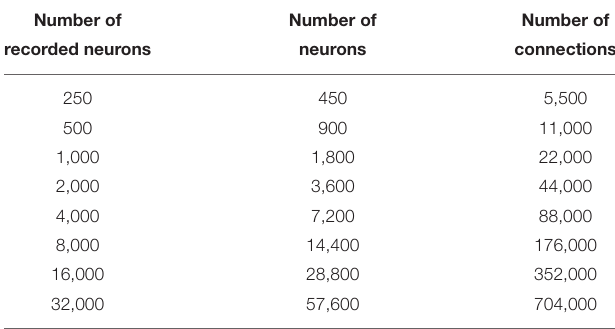
TABLE 2 | Overview on the network model sizes used for the computational time analysis. Number of Number of Number of recorded neurons